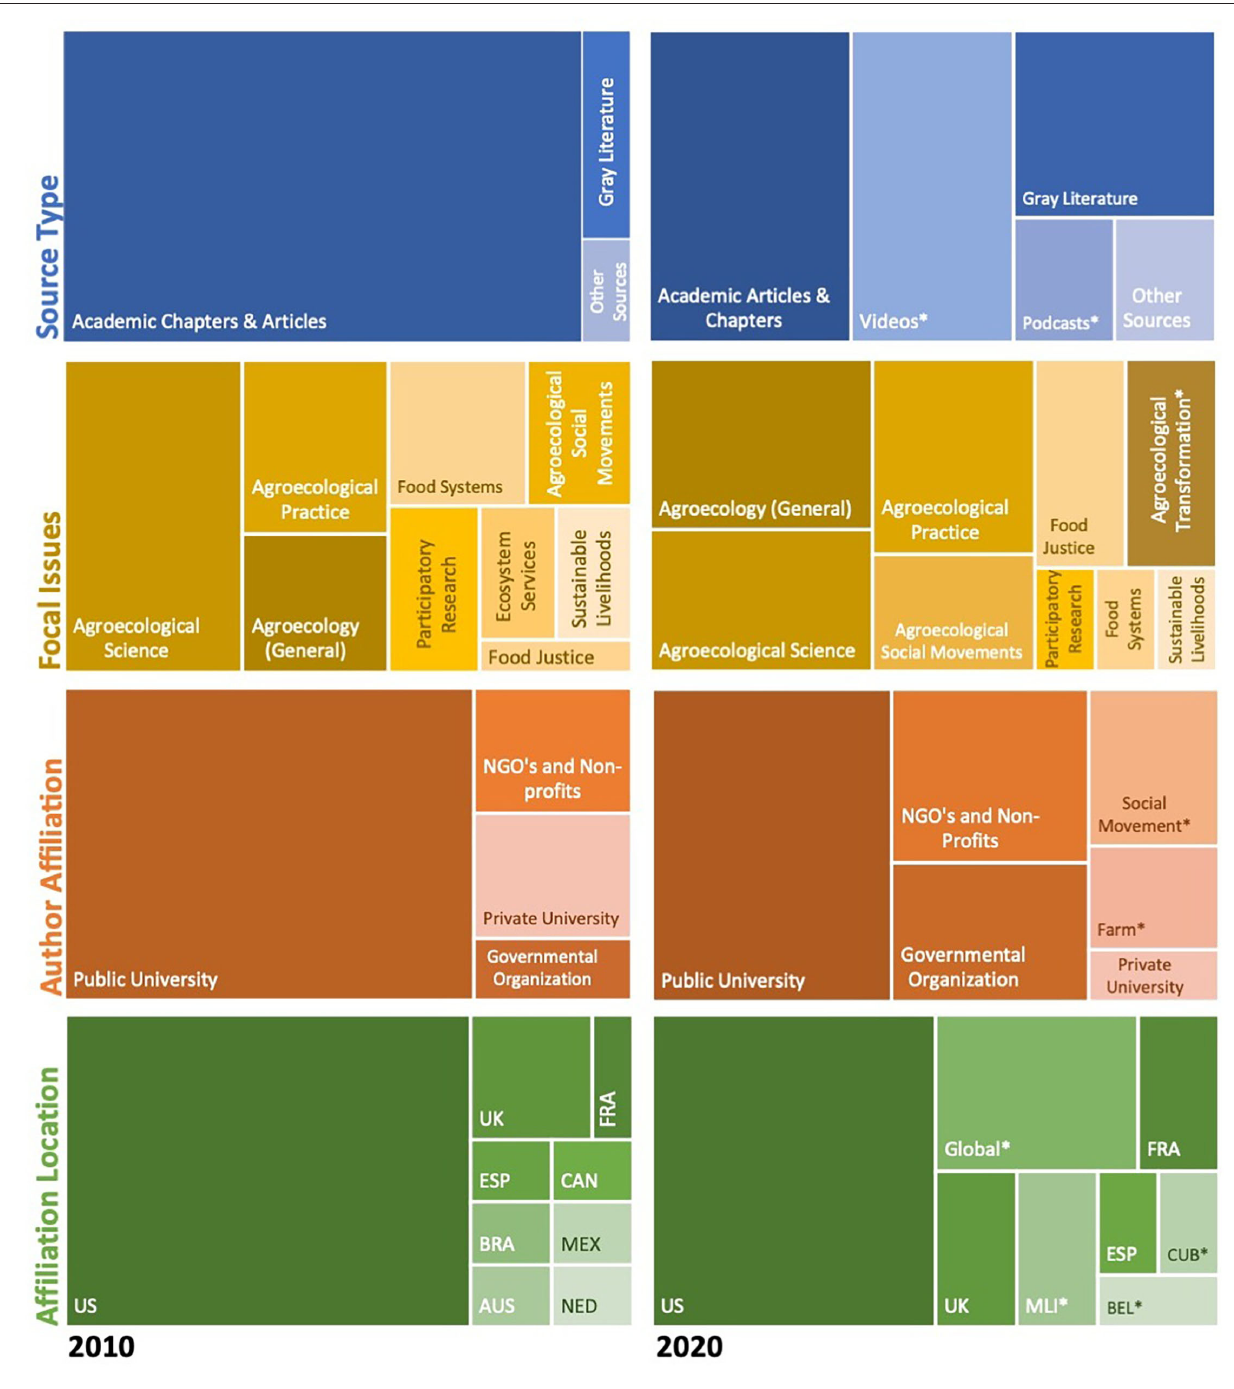
FIGURE 2 | Comparative content analysis of assigned course materials in 2010 and 2020. The size of sub-rectangles represents the quantity of sources of that type in the respective year’s syllabus. Gray Literature includes policy briefs, research briefs, and content from popular books and news print sources. “Other sources” includes movement manifestos and encyclopedia entries. *New in the 2020